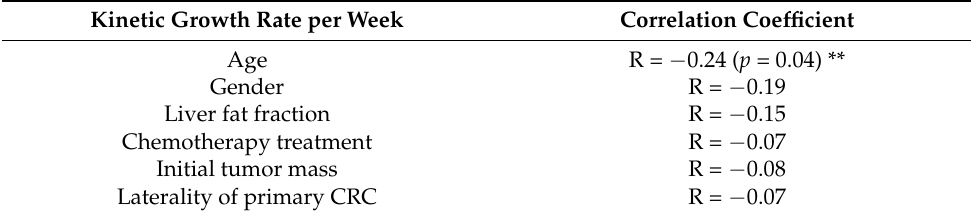
Table 5. Correlation coefficient multivariable analysis; ** p < 0.05, statistically significant.